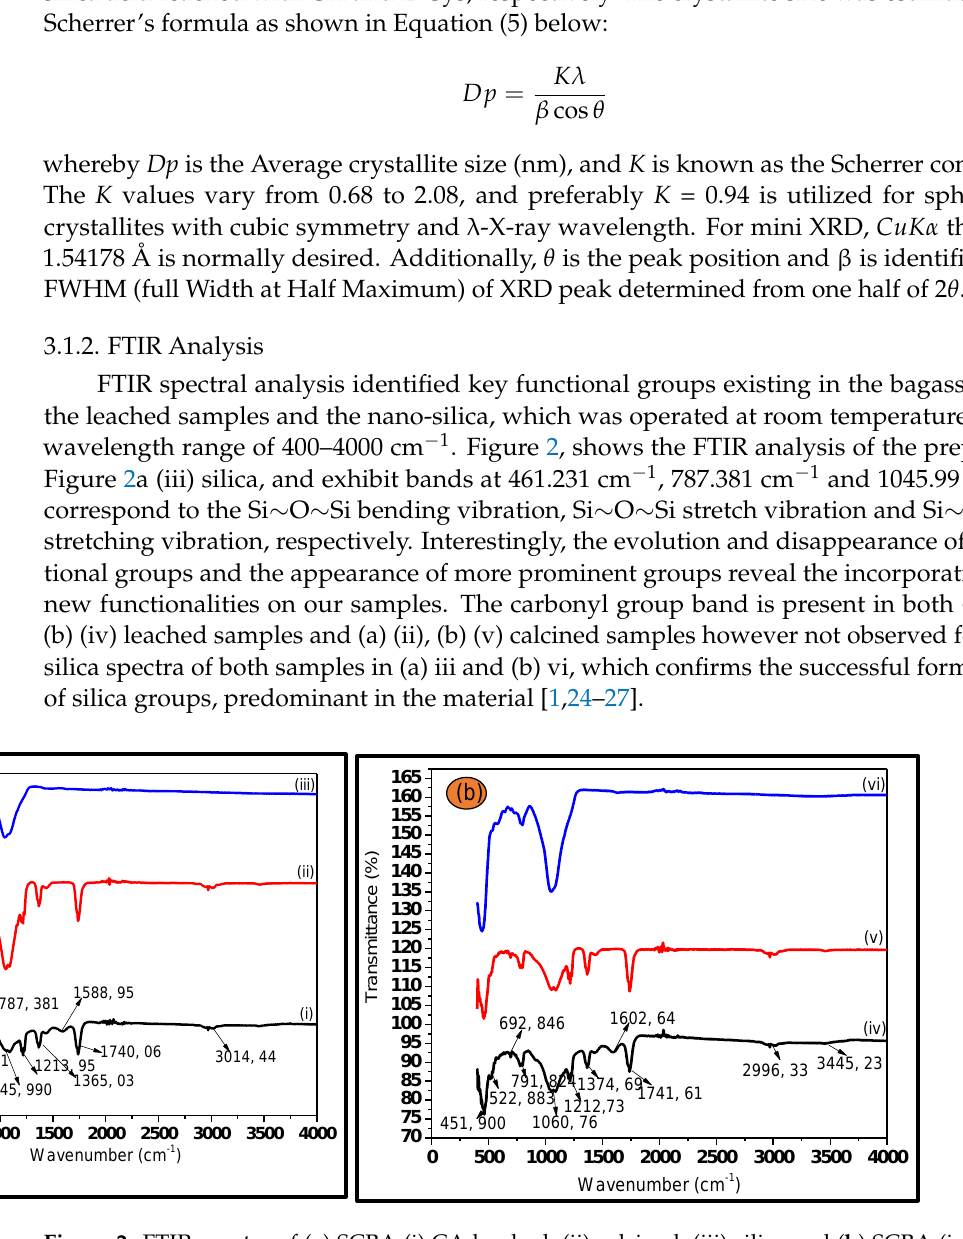
Figure 2. FTIR spectra of ( a ) SCBA (i) CA leached, (ii) calcined, (iii) silica and ( b ) SCBA (iv) acid- leached with L-Cysteine Hydrochloride, (v) calcined and (vi) Silica. Similarly, the results obtained for as-produced (vi) silica in Figure 2b showed identical behavior of new functionalities. The bands at 451. 900 cm −1 , 791.803 cm −1 and 1060.76 cm −1 are attributed to the Si ~ O ~ Si bending vibration, the Si ~ O ~ Si stretch vibration and the Si ~ O ~ Si stretching vibration [1,28].